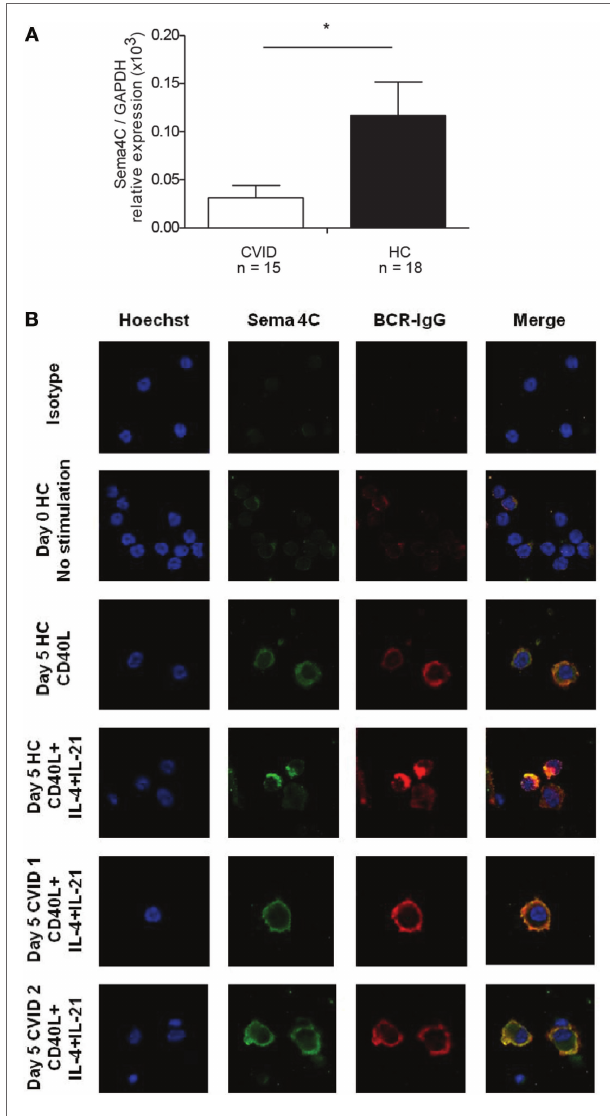
FigUre 8 | Patients with common variable immunodeficiency (cViD) have lower sema4c mrna and protein expression and impaired synapse-like pole formation . (a) Peripheral blood mononuclear cells (PBMCs) were purified and mRNA extracted. Sema4C mRNA expression was evaluated by semi-quantitative RT-PCR. CVID subjects showed significantly lower basal Sema4C mRNA expression (compared to the GAPDH reference gene) than healthy controls without immune deficiency (HC) (* p = 0.04, Mann–Whitney test). (B) PBMC from healthy controls and subjects with CVID were stimulated for 5 days in vitro with anti-CD40 antibodies + IL-4 + IL-21. Representative confocal microscopy: HC demonstrated increased expression of Sema4C as well as synapse-like structure formation colocalizing Sema4C with BCR. The two lower panels demonstrate two independently chosen CVID subjects showing membranous Sema4C protein expression and no synapse-like structure formation following 5 days of stimulation with anti-CD40 + IL-4 +